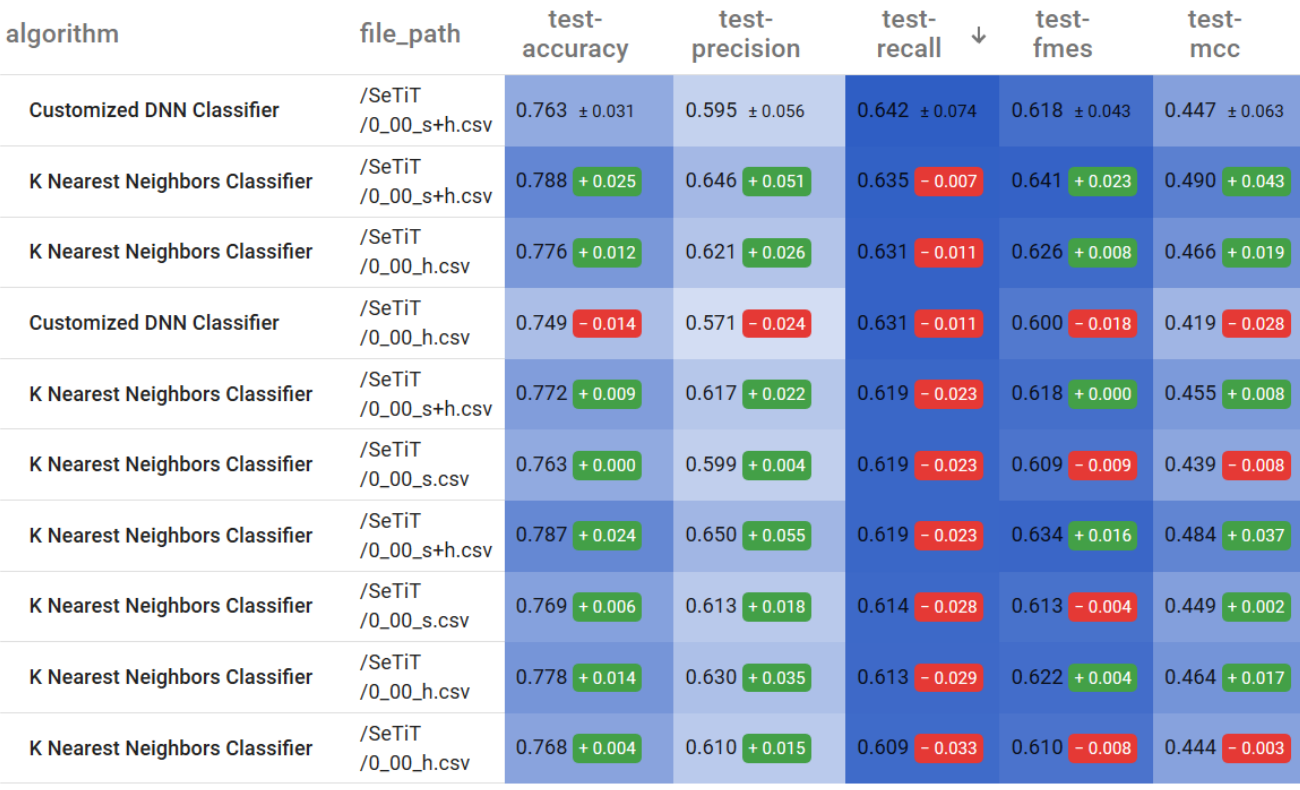
Figure 4. Top 10 recall